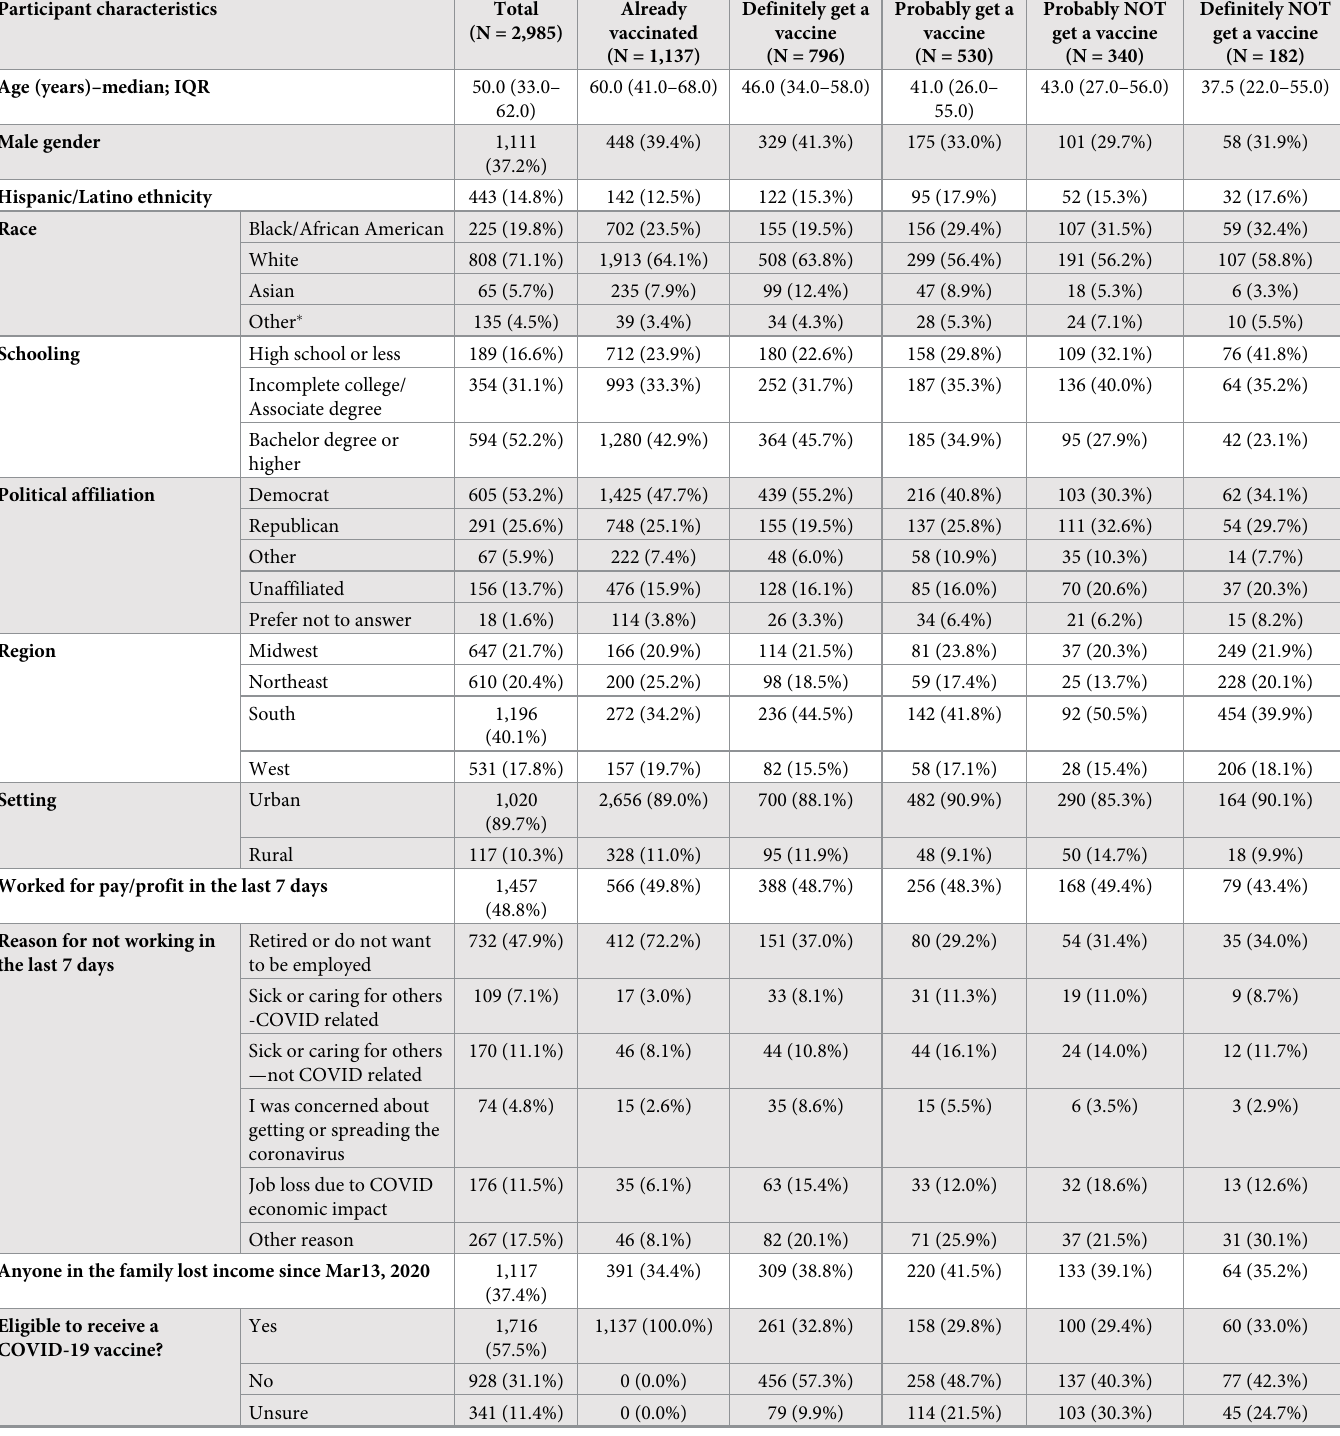
Table 2. Characteristics and COVID experiences of